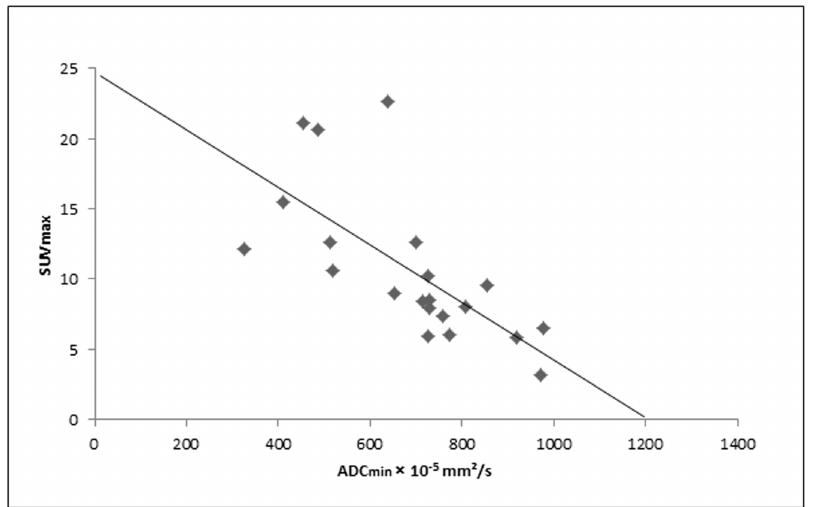
Figure 2. Scatter plot demonstrating a significant inverse correlation between the ADC min and the SUV max for primary cervical cancer lesions and associated lymph node metastases. (n=21; R= 2 0.692; p , 0.05).